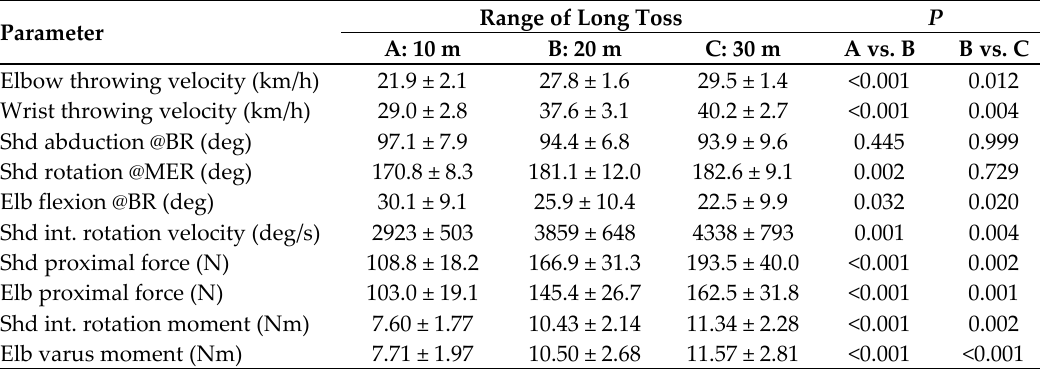
Table 3. Throwing kinematics and kinetics of subjects who threw short-range: n =